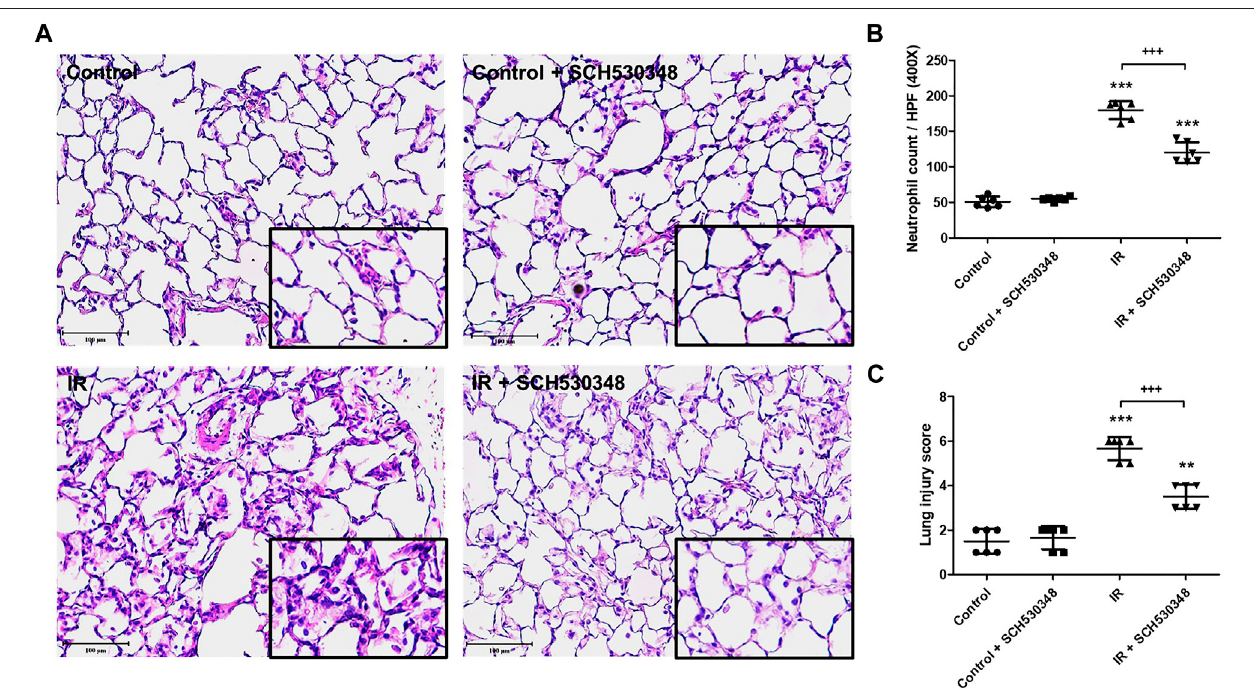
FIGURE 4 | SCH530348 mitigated IR-induced acute lung injury. (A) HE staining of lung tissue showed thickening of alveolar septa and neutrophil in fi ltration in the interstitial and alveolar spaces after IR injury compared with that of the sham control. Alveolar damage and neutrophil recruitment after IR injury were attenuated by SCH530348 treatment. (B) The number of in fi ltrated neutrophils per high-power fi eld (400x magni fi cation) was elevated in the IR group, while additional SCH530348 signi fi cantly reduced the number of neutrophils in the context of IR injury. (C) SCH530348 signi fi cantly decreased IR-induced elevations in lung injury scores. Cell countingwasperformedat400xmagni fi cation;scalebar (cid:1) 100 μ m.Thedataareexpressedasthemean ± SD( n (cid:1) 6pergroup).** p < 0.01,*** p < 0.001,comparedwith the control group; +++ p < 0.001, compared with the IR